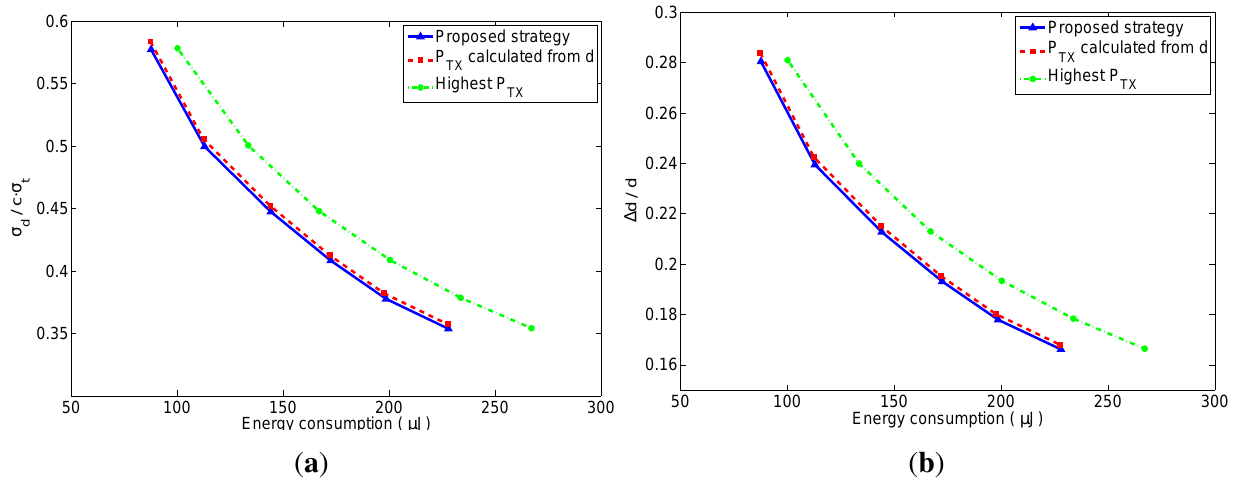
Figure 13. Relation between the average energy consumption per localization and the distance estimation accuracy for the three strategies for l = 4 bytes. ( a ) TOA-based localization; ( b ) RSS-based